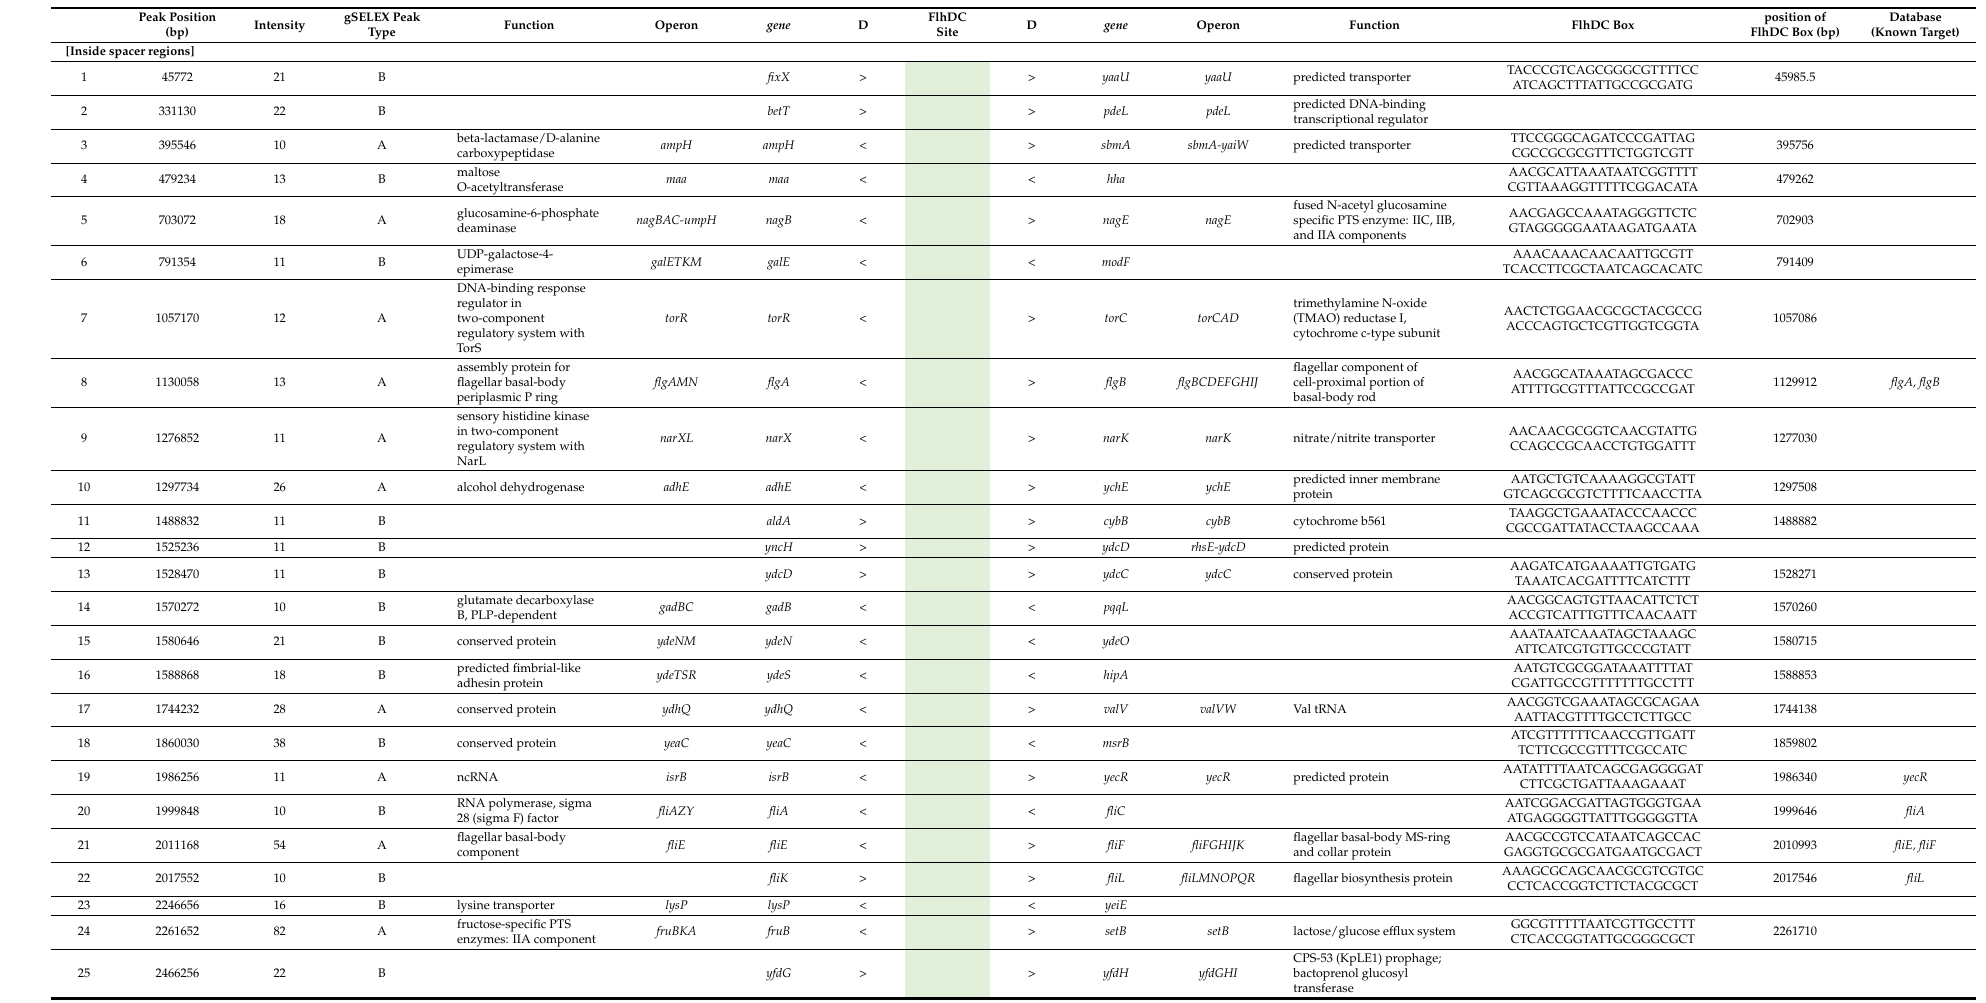
Table 1. FlhDC-binding sites on the E. coli